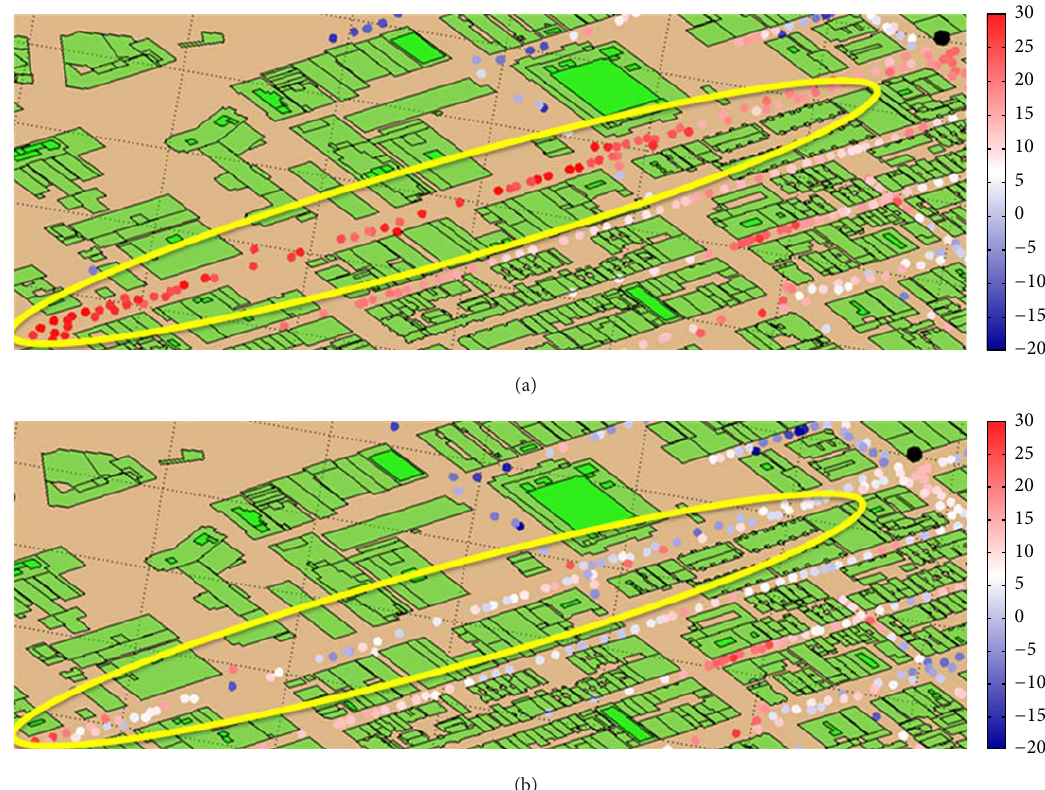
Figure 7: Impact of the ray selection method in urban street canyons: (a) error map [dB] obtained including rays with multiple reflections/diffractions; (b) error map obtained including only LOS ray in the street canyon [site A0000A49; BS position is shown as a black